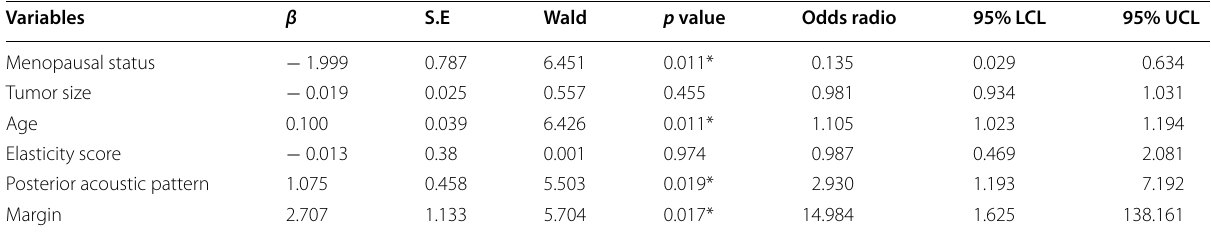
LCL , lower control limit; UCL , upper control limit; * indicates p < 0.05